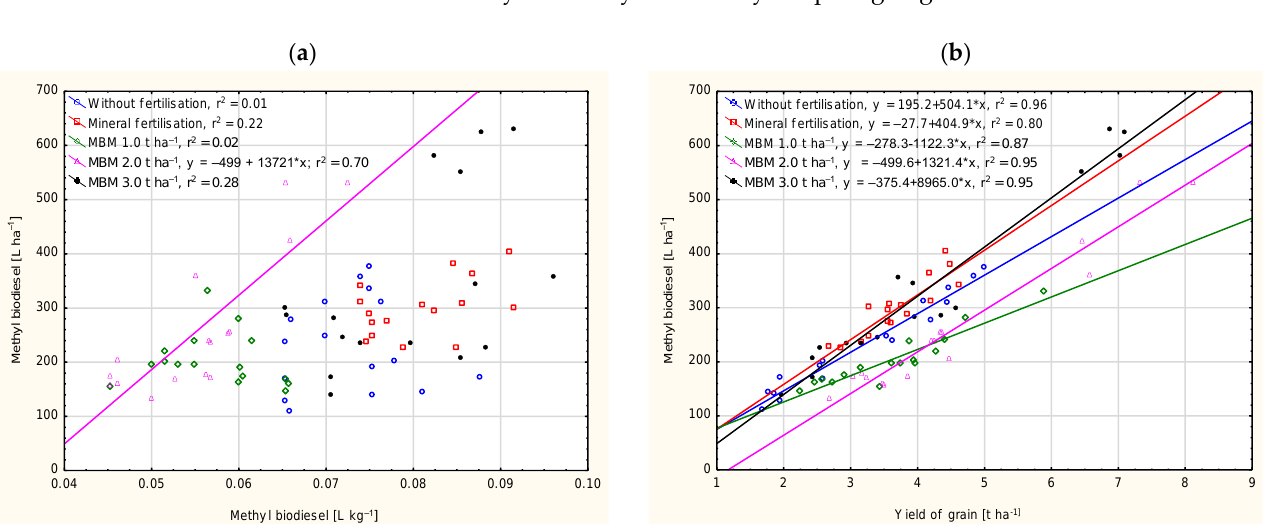
Figure 13. Dependence of methyl biodiesel yield on volume obtained from 1.0 kg – 1 of grain ( a ) and grain harvest from 1.0 ha – 1 ( b ) (calculated at significance α = 0.05). MBM— Meat and Bone Meal.